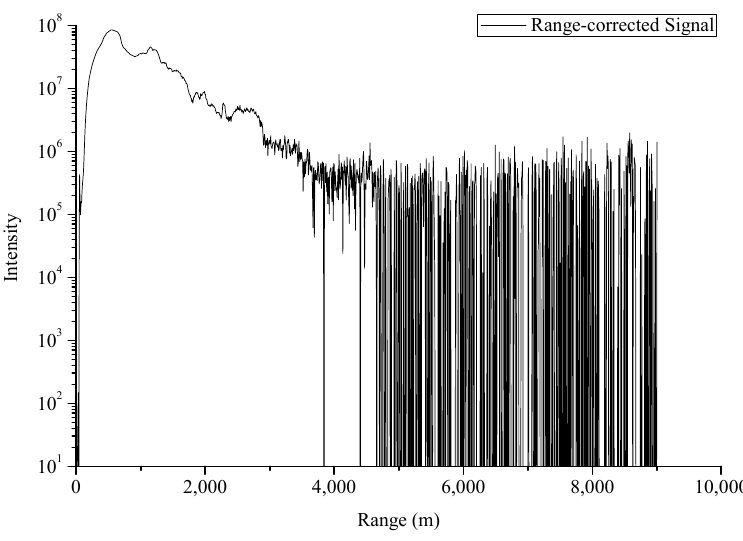
Figure 11. Lidar signal corrected by distance (30 July 2016).